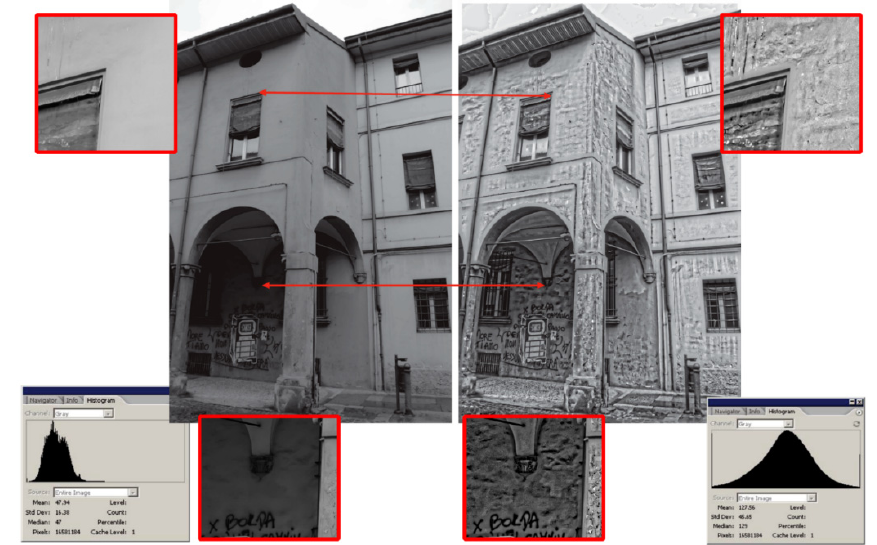
Figure 9. Example of the Wallis filtering procedure: note the much smoother and Gaussian-like Example of the Wallis filtering procedure: note the much smoother and histogram. Gaussian-like